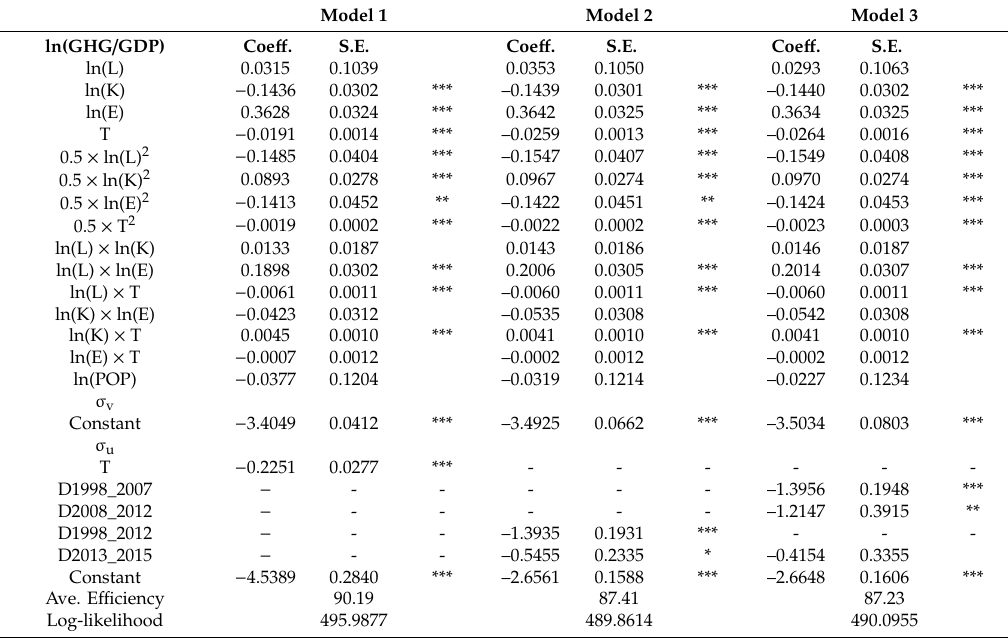
Table 2. Estimation results for greenhouse gases (GHG) emission e ffi ciency model.